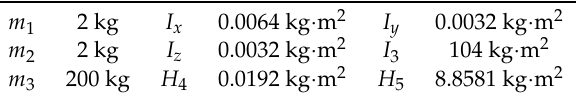
Table 3. Inertial parameters.